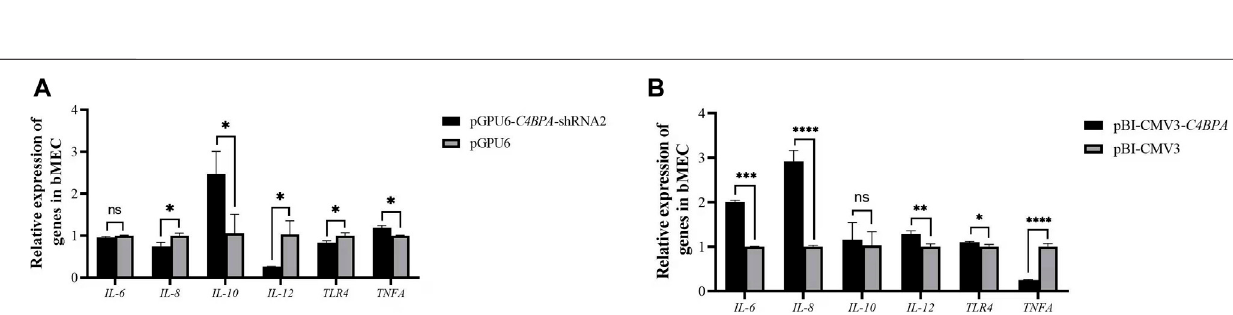
FIGURE 5 | (A) The relative mRNA expression of in fl ammatory factors in bMECs after transfection with pGPU6- C4BPA -shRNA2 vector. (B) The relative mRNA expression of in fl ammatory factors in bMECs after transfection with pBI-CMV3- C4BPA